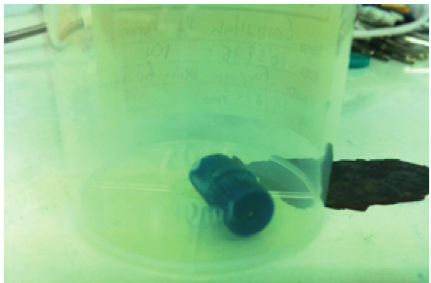
Figure 4: The foreign body is managed to remove from the right lower lobe, and it is a pen